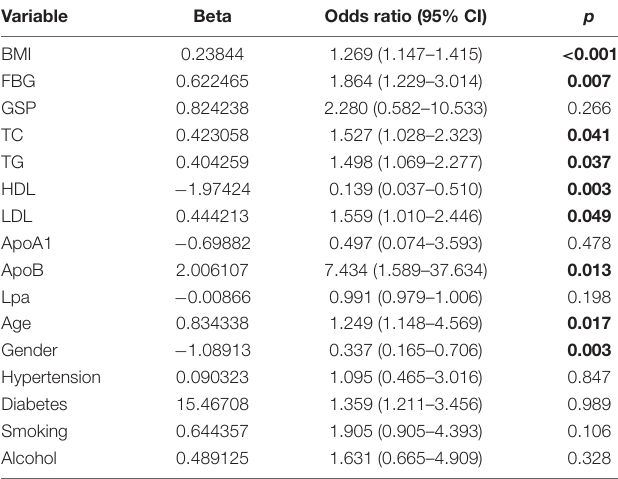
TABLE 2 | Results of univariate Logistic Regression analysis based on 16 variables.